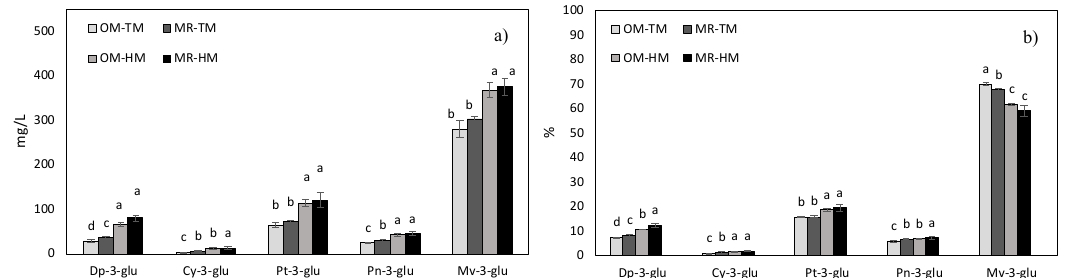
Figure 4. Concentration ( a ) and proportion ( b ) of different anthocyanidin forms. Average of nine wines ± standard deviation. Different letters indicate statistical differences ( p < 0,05). OM-TM: original must and traditional maceration; MR-TM: must replacement and traditional maceration; OM-HM: original must and hot pre-fermentative maceration; MR-HM: must replacement and